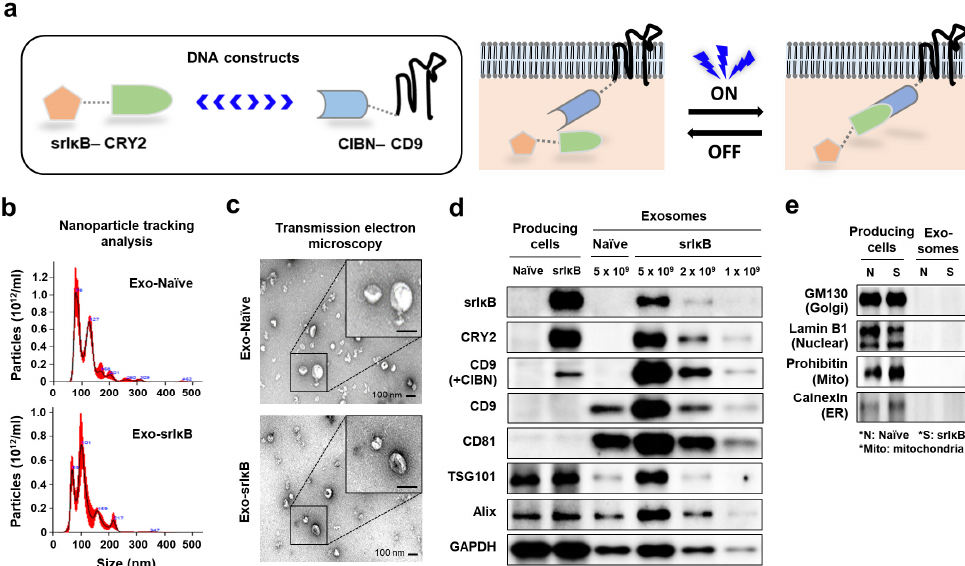
Figure 1. Generation and characterization of Exo-srI κ B. ( a ) Schematic diagrams for DNA constructs ( left ) and the blue-light-mediated fusion of recombinant proteins ( right ) in producing Exo-srI κ B. ( b ) Representative panels for nanoparticle tracking analysis. ( c ) Representative images for trans- mission electron microscopy of Exo-Naïve and Exo-srI κ B. ( d , e ) Western blot analysis of Expi293F cells (producing cells) and Expi293F cell-derived exosomes to analyze the expression of recombinant proteins (srI κ B and CD9) and exosome markers (CD9, CD81, TSG101, Alix, and GAPDH) ( d ), and cell organelle markers (GM130, lamin B1, prohibitin, and calnexin) ( e ). CIBN, N-terminal fragment of cryptochrome-interacting basic-helix-loop-helix 1; Exo-srI κ B, srI κ B-loaded exosomes; GAPDH, glyceraldehyde-3-phosphate